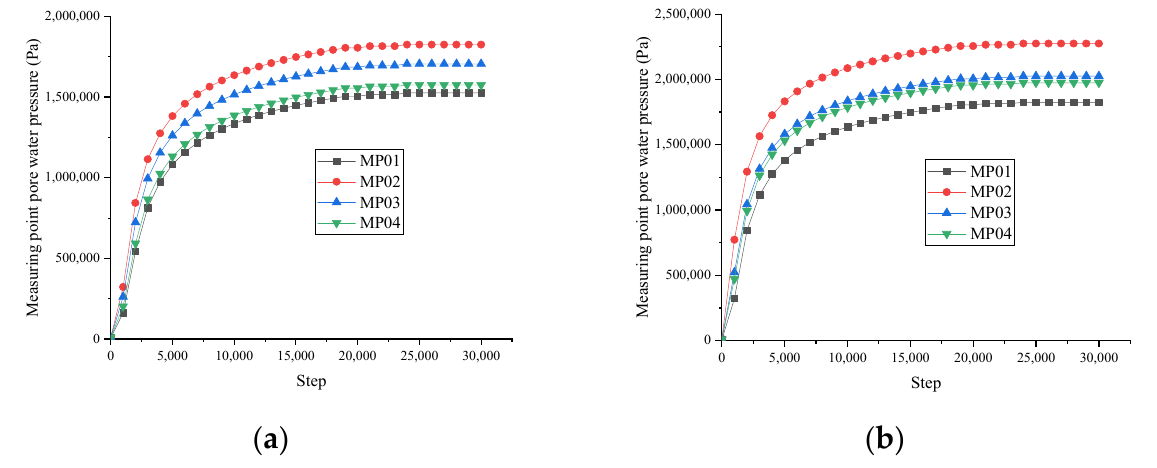
Figure 14. Simulation of pore water pressure changes at measuring points. ( a ) S1ZK0 + 660 m; ( b ) S1ZK0 + 735 m. It can be seen from Figure 15 that the error range between the simulation results and measured data was − 5% to 10%, thus indicating that the simulation results are reasonable. unevenly distributed in different directions, which is consistent with the monitoring